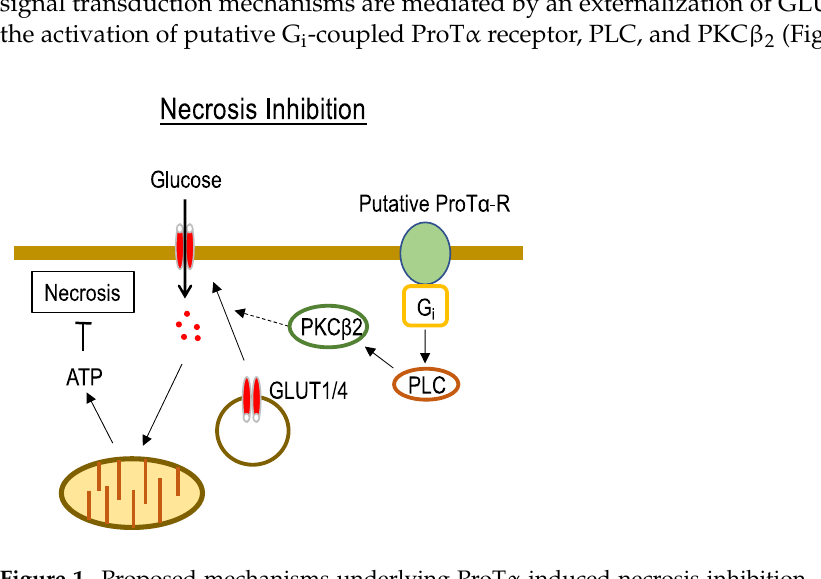
Figure 1. Proposed mechanisms underlying ProT α‐ induced necrosis inhibition. ProT α activates putative G i -coupled receptor, followed by an activation of PLC and PKC- β 2, which contributes to the translocation of GLUT1/4 to the plasma membrane. GLUT1/4 causes a glucose influx and increases intracellular glucose levels via the glycolysis pathway. As a result, intracellular ATP levels increase and prevent necrosis. More details are described in the text.